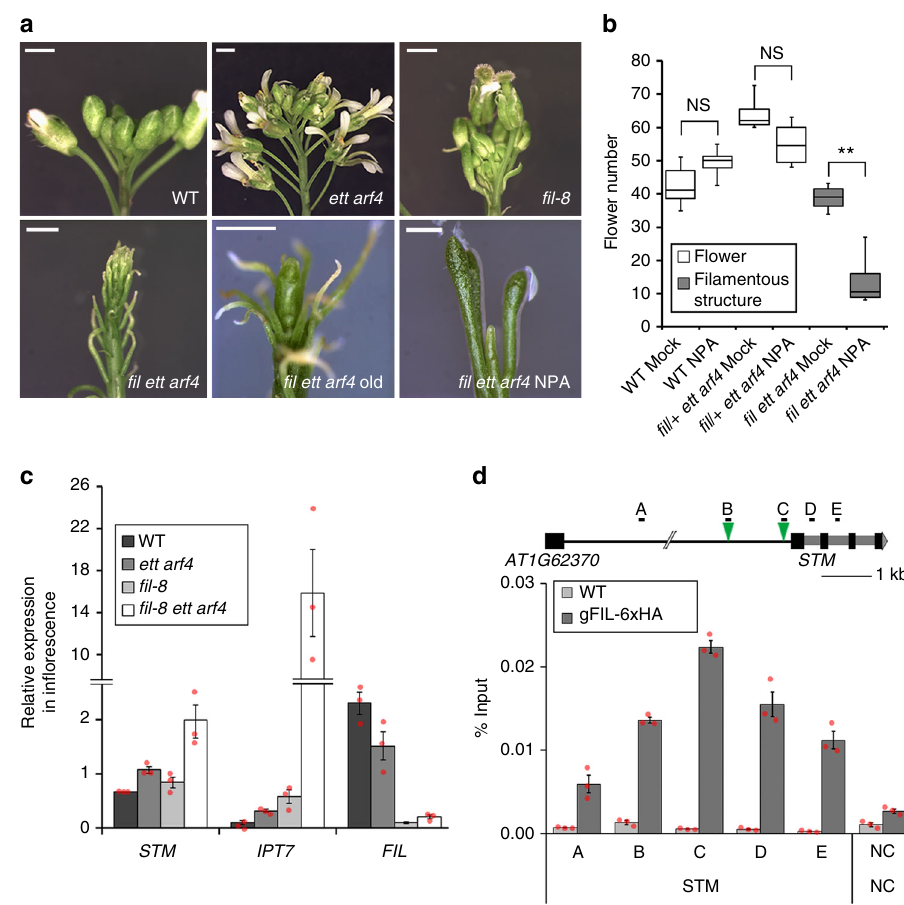
Fig. 5 The MP target FIL promotes fl ower initiation together with ETT/ARF4. a Flower initiation phenotypes of wild type (WT), ett arf4 , fi l-8 , young and old fi l-8 ett arf4 and auxin transport inhibitor (NPA) treated fi l ett arf4 plants. NPA (500 nM), was applied from 11 days of age until bolting. Scale bar = 1 mm. b Quanti fi cation of lateral organs formed in the absence and presence of NPA. Box and whisker plot: Lower vertical bar = sample minimum. Lower box = lower quartile. Black Line = median. Upper box = upper quartile. Upper vertical bar = sample maximum. P -values ( ± NPA): NS P = 0.11 (WT), NS P = 0.73 ( fi l / + ett arf4 ) and * P = 0.006 ( fi l ett arf4 ), one-tailed Mann – Whitney U test. n = 7 (WT mock) n = 5 (WT NPA) n = 4 ( fi l/ + ett arf4 mock), n = 4 ( fi l/ + ett